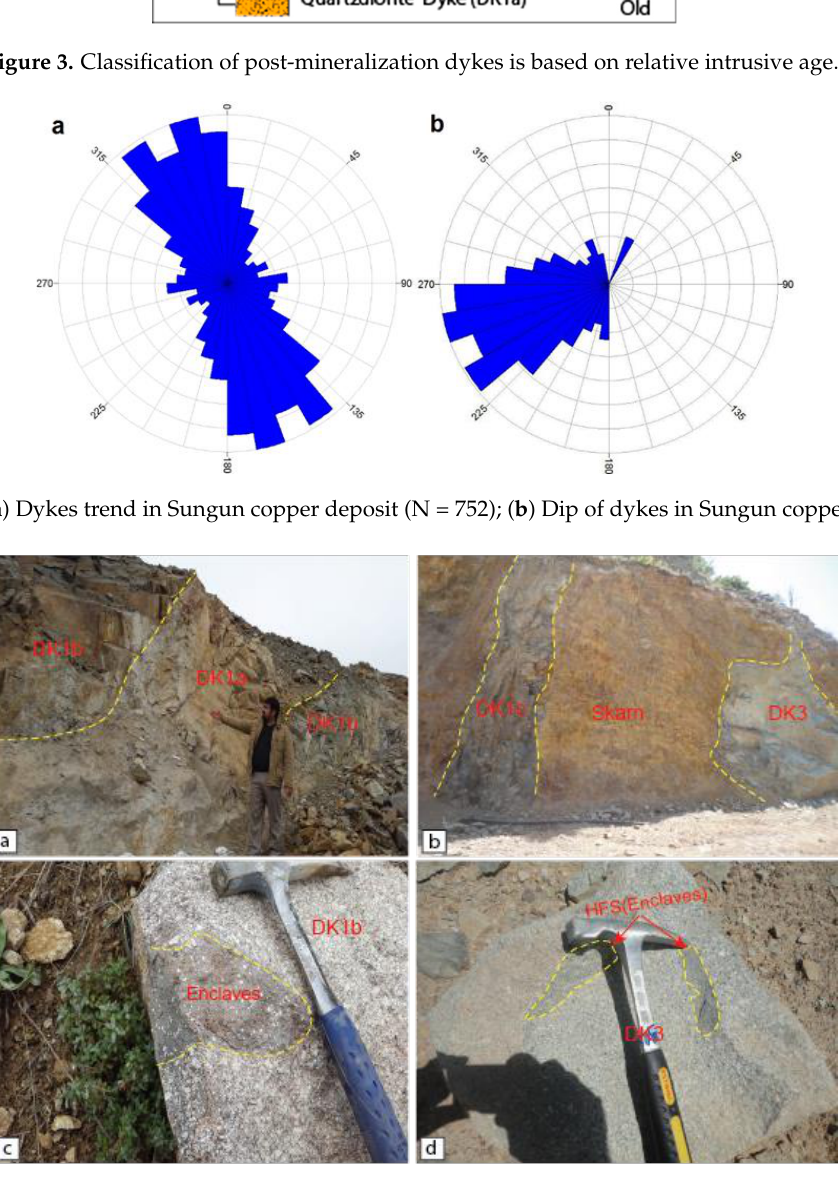
Figure 5. Field photographs. ( a ) Quartz diorite (DK1b) dykes intruded into the quartz diorite (DK1a), view to the North; ( b ) quartz diorite (DK1c) and diorite (DK3) dykes intruded into the skarn, view to the SE; ( c ) Irregular mingled contact between fine-grained enclave and medium-grained quartz diorite (DK1b); and ( d ) hornfels enclave within an outcrop of fine-grained diorite (DK3). Gabbroic dykes (DK2) have not been seen inside the Sungun deposit but are found on its Northeastern side. Gabbroic rocks (DK2) are dark grey in colour. This dyke group cuts quartz-diorite